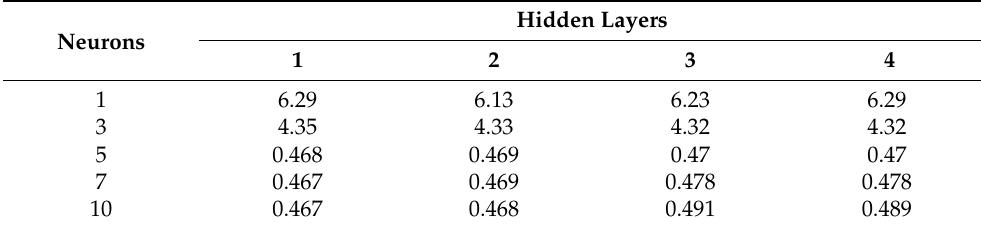
Table 13. CRMSE for real part approximations. Neurons